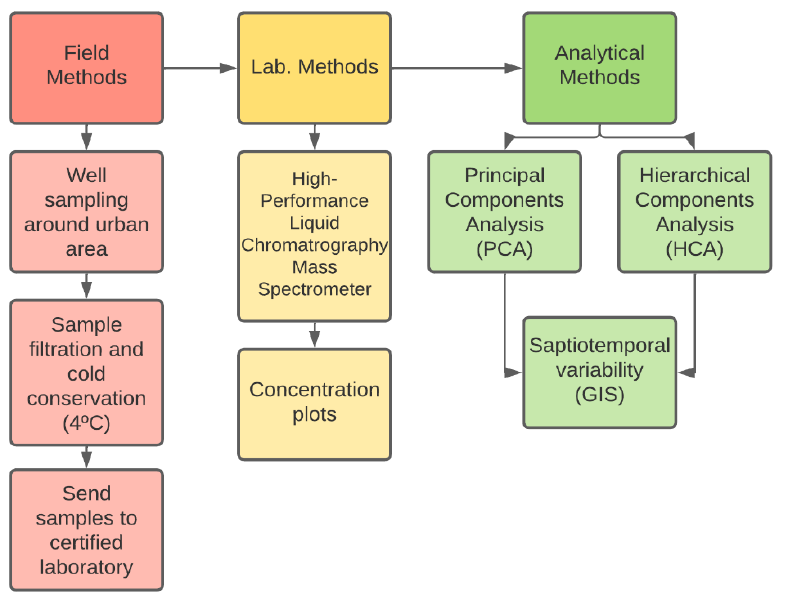
Figure 2. Schematic flow diagram of research methods and data acquisition.